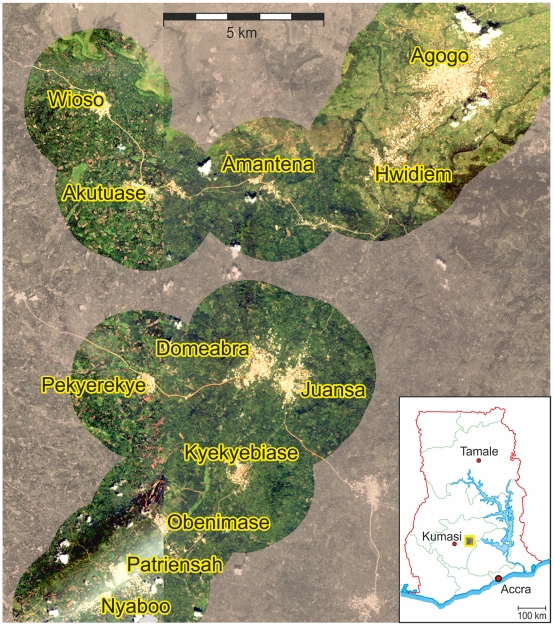
Map of the 12 included study villages.Merger of two satellite images (Ikonos) depicting an area with 12 study villages in the Asante Akim North District, Ashanti Region, central Ghana, West Africa. Areas with a radius of 2 km surrounding the study villages, which were analysed by supervised maximum likelihood classification, are coloured.